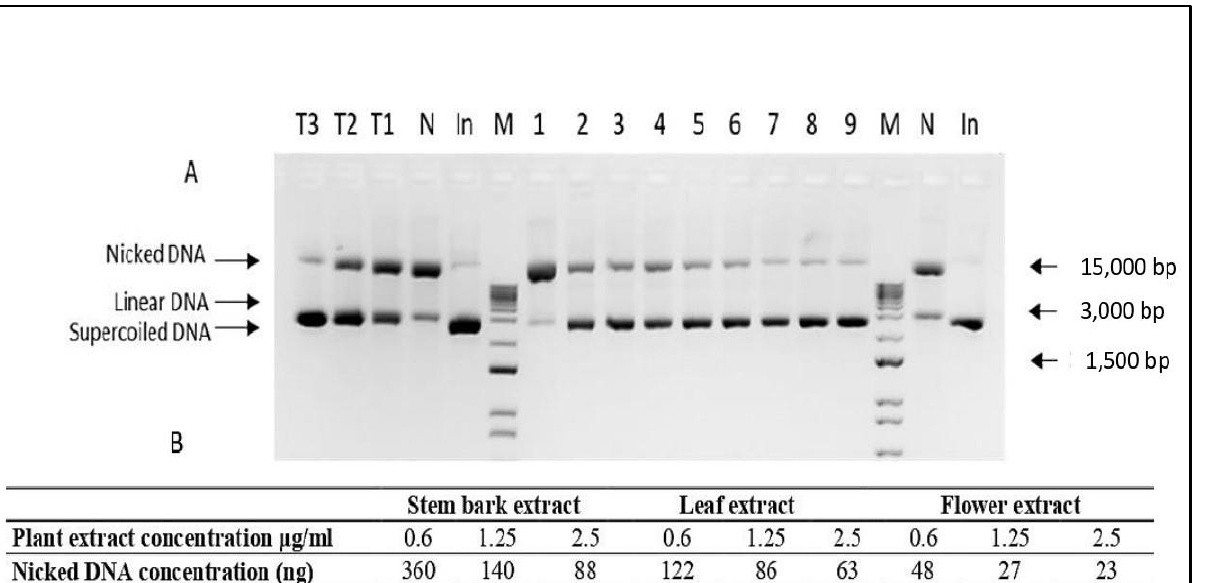
Figure 1. DNA nicking protection assay with ( A ) 1.5% agarose gel electrophoresis, and ( B ) relative concentration of necked plasmid DNA. 1 – 3 — A. altissima stem bark extract at concentrations of 0.6, 1.25, and 2.5 μg /mL; 4 – 6 — A. altissima leaf extract at concentrations of 0.6, 1.25, and 2.5 μg/mL; 7– 9 — A. altissima flower extract at concentrations of 0.6, 1 .25, and 2.5 μg/mL. T3—Trolox 100 μg/mL;